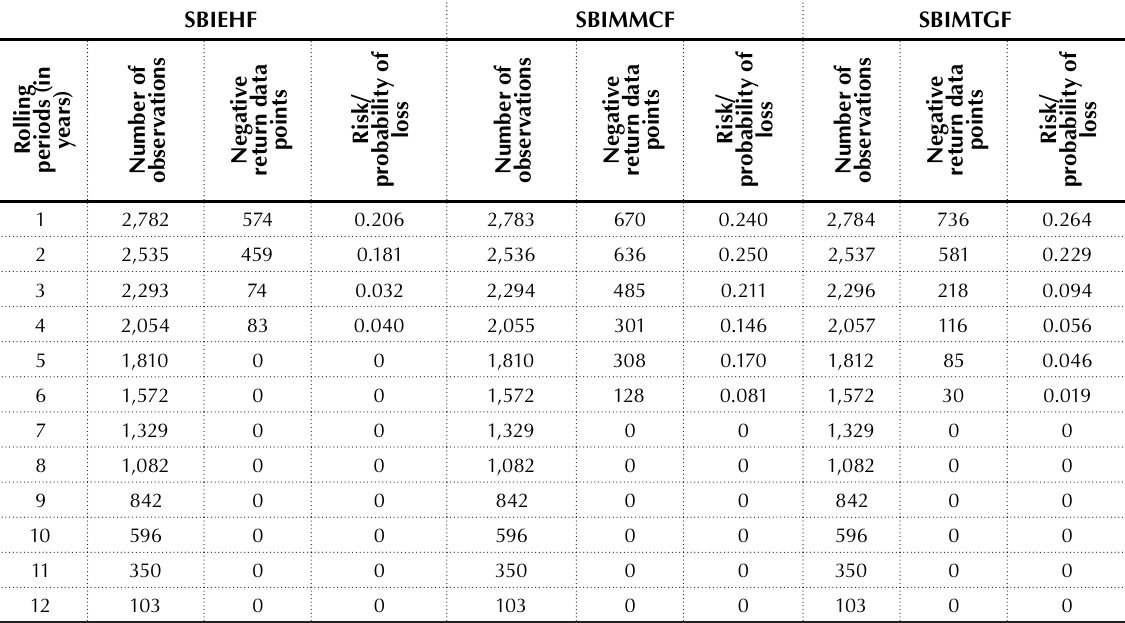
Table 19. Rolling period risk and return behavior of SBIEHF, SBIMMCF and SBIMTF (2006–2018)